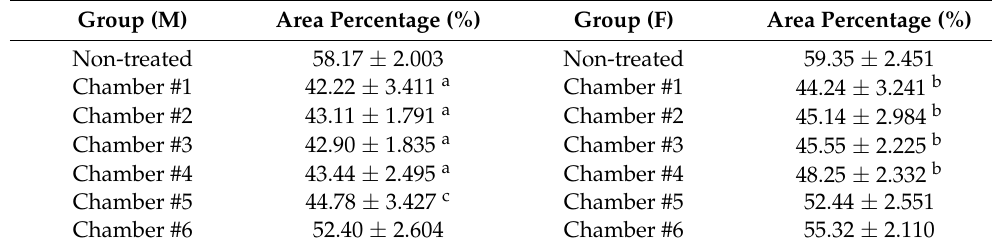
Table 6. Area percentage (%) of space occupied by the lumen of the alveolar sac per unit